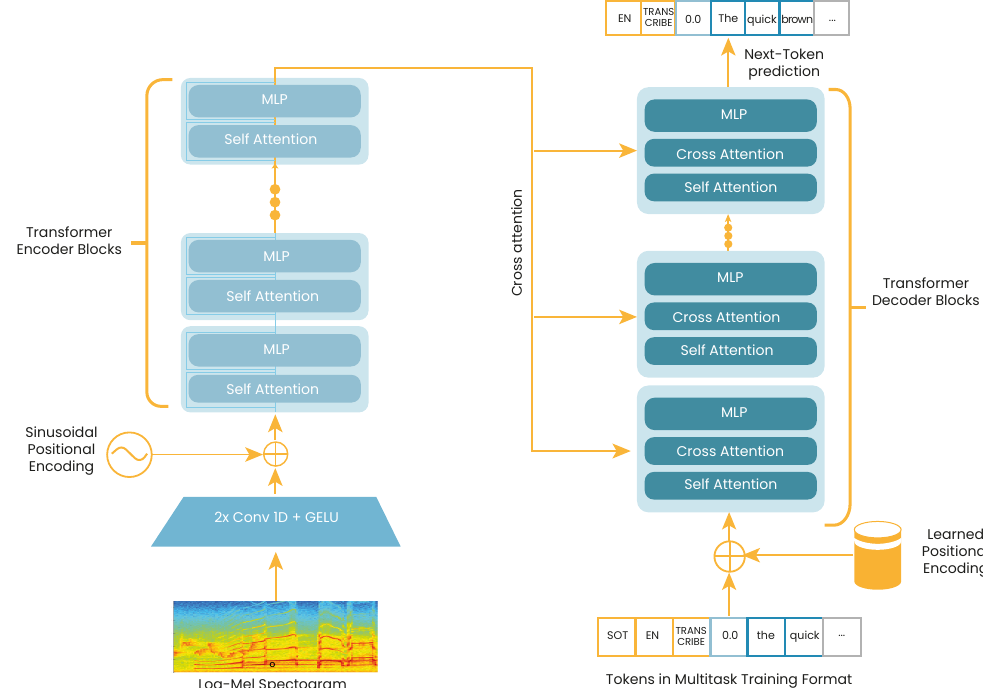
Figure 2. Whisper architecture representation. The log Mel-spectrograms are encoded by a trans- former network. Encoded representations are transformed into character outputs and no-speech tokens via the transformer decoder. Figure based on the one presented in